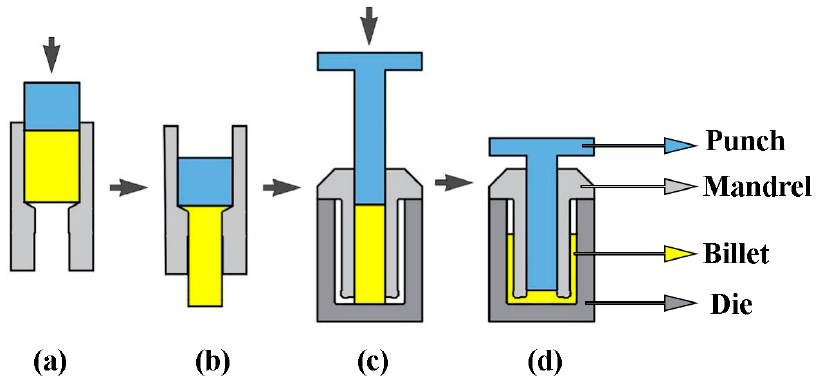
Figure 1. Diagram of forming process ( a ) upsetting, ( b ) extrusion, and ( c , d ) the beginning and ending stage of annular channel angular extrusion.